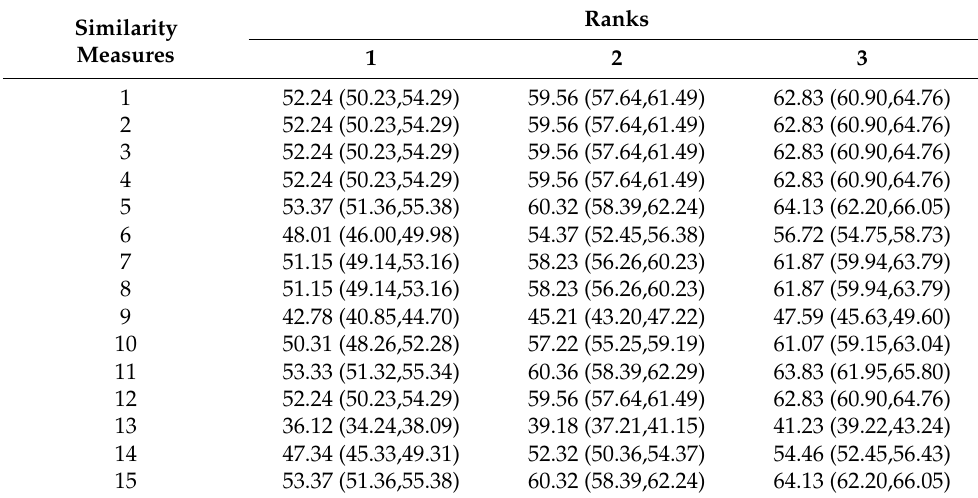
Table 2. Accuracy and 95% CI of all 15 binary similarity measures for ESI mass spectra-based com- pound identification up to top three highest similarity scores.